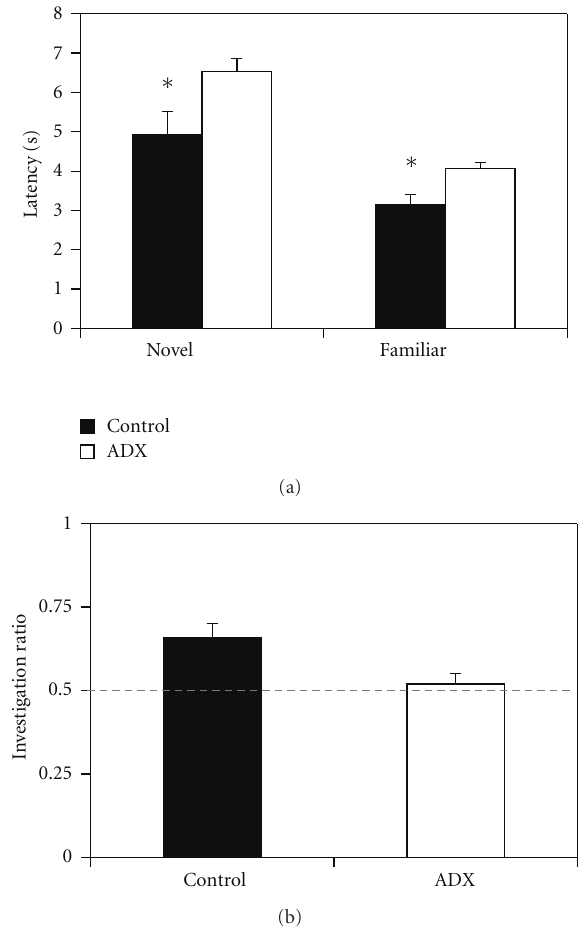
Figure 4: Behavioural deficits associated with long-term ADX. (a) ADX rats were impaired relative to controls at locating both novel and familiar platform locations in a moving platform version of the Morris water task. (b) Discrimination ability of ADX rats in the object/context mismatch task was significantly impaired. ADX ratsdid notdiscriminate above chance levels. Dashed lines represent chance, error bars represent standard error of the